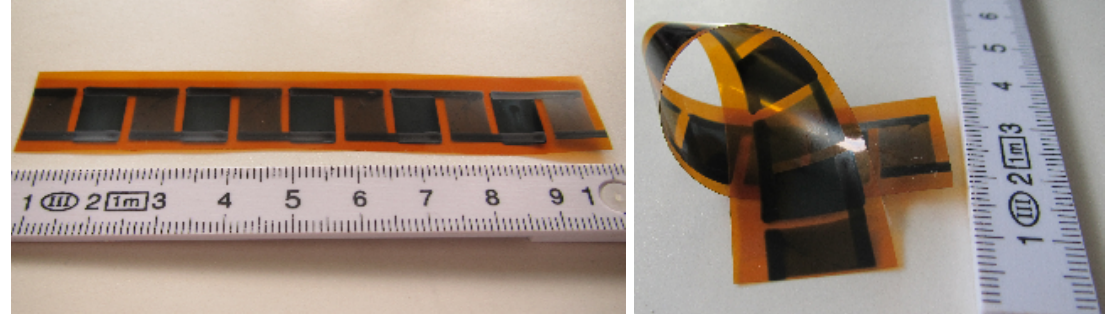
Figure 6. Dispenser printed fully flexible TEG. The performance of the TEG stripe does not change after winding on a cylinder with a diameter of 8 mm.